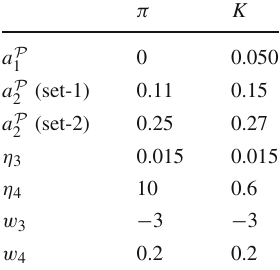
Table 2 Parameters of the wave function calculated at the renormalization scale μ = 1